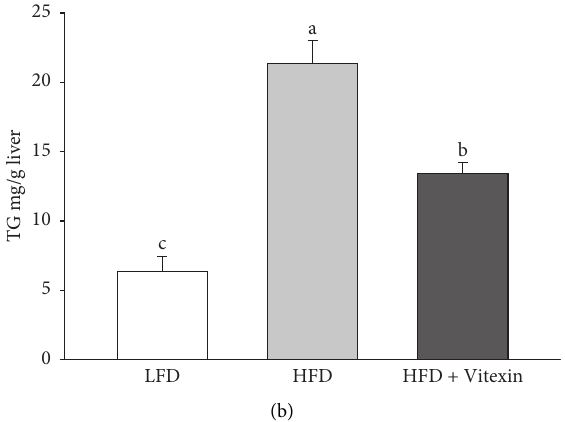
Figure 3: Effects of vitexin on liver morphology and triglyceride level. Mice were fed with low-fat diet (LFD), high-fat diet (HFD) or HFD containing 5mg vitexin/kg BW/day (HFD+Vitexin) for 8 weeks. (a) Representative pictures of the liver after H&E staining; (b) liver triglyceride. Data were expressed as the mean ± SE ( n � 4). Means with different letters were significantly different at P < 0 . 05.